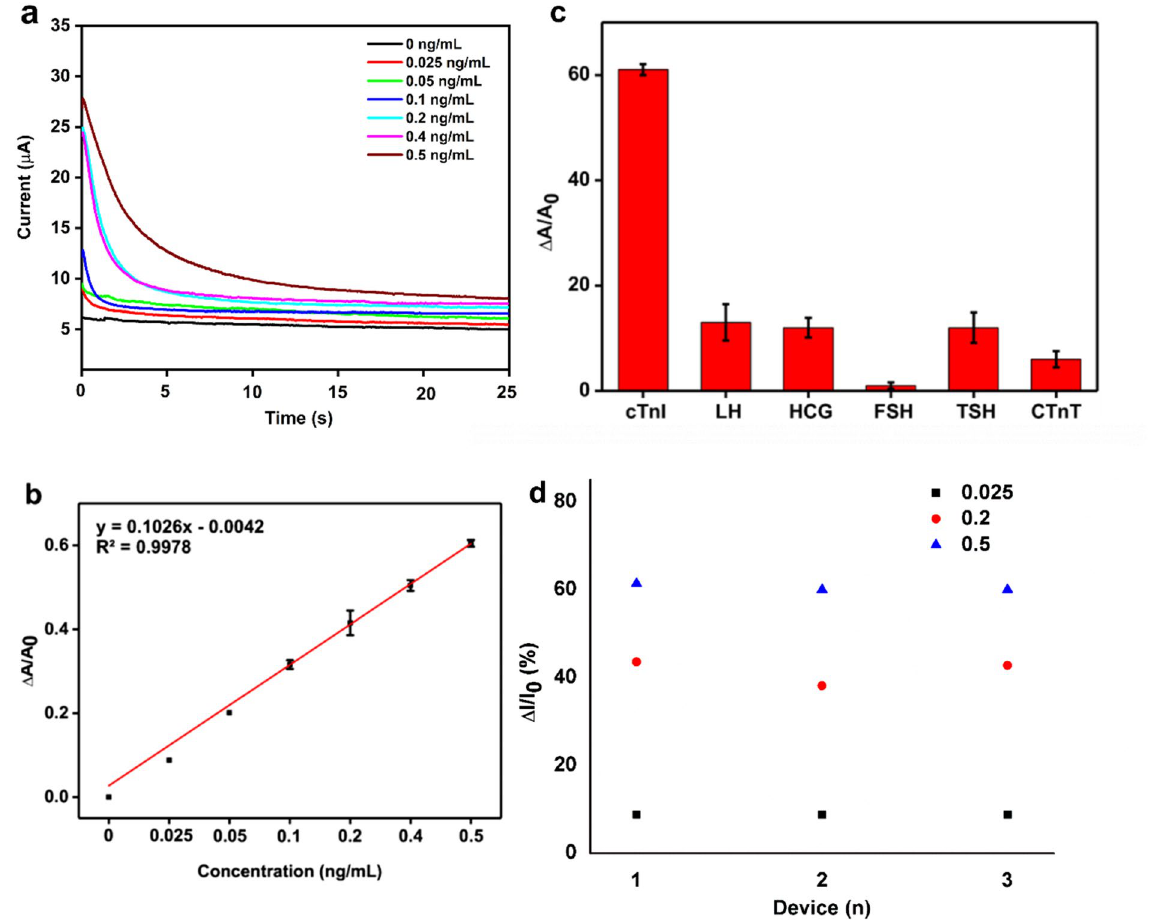
functionalized SiNW-FET surface, determined by the current changes. ( d ) The electrical response of a three sensor chips obtained from three different batches to detect three different cTnI concentratios (0.025 ng/mL, 0.2 ng/mL and 0.5